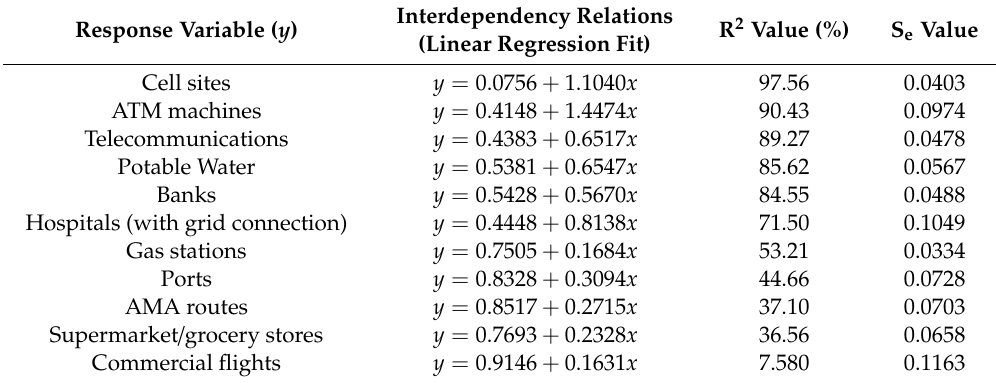
Table 1. Interdependency relations between the power system (predictor variable, x ) and other CIS (response variables, y